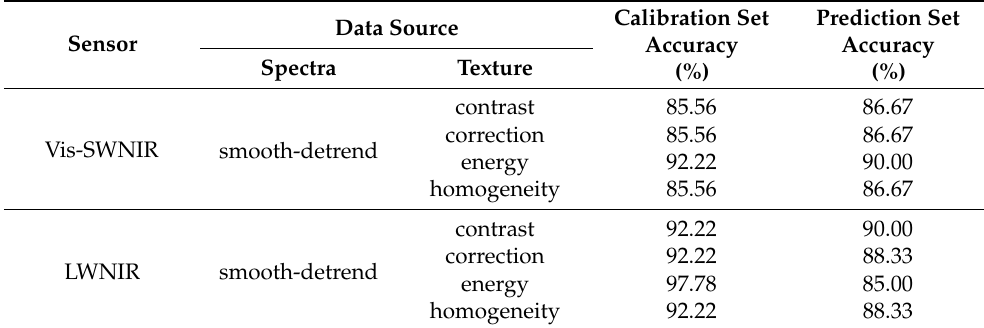
Table 4. The classification results of the pixel-level fusion of spectral and texture